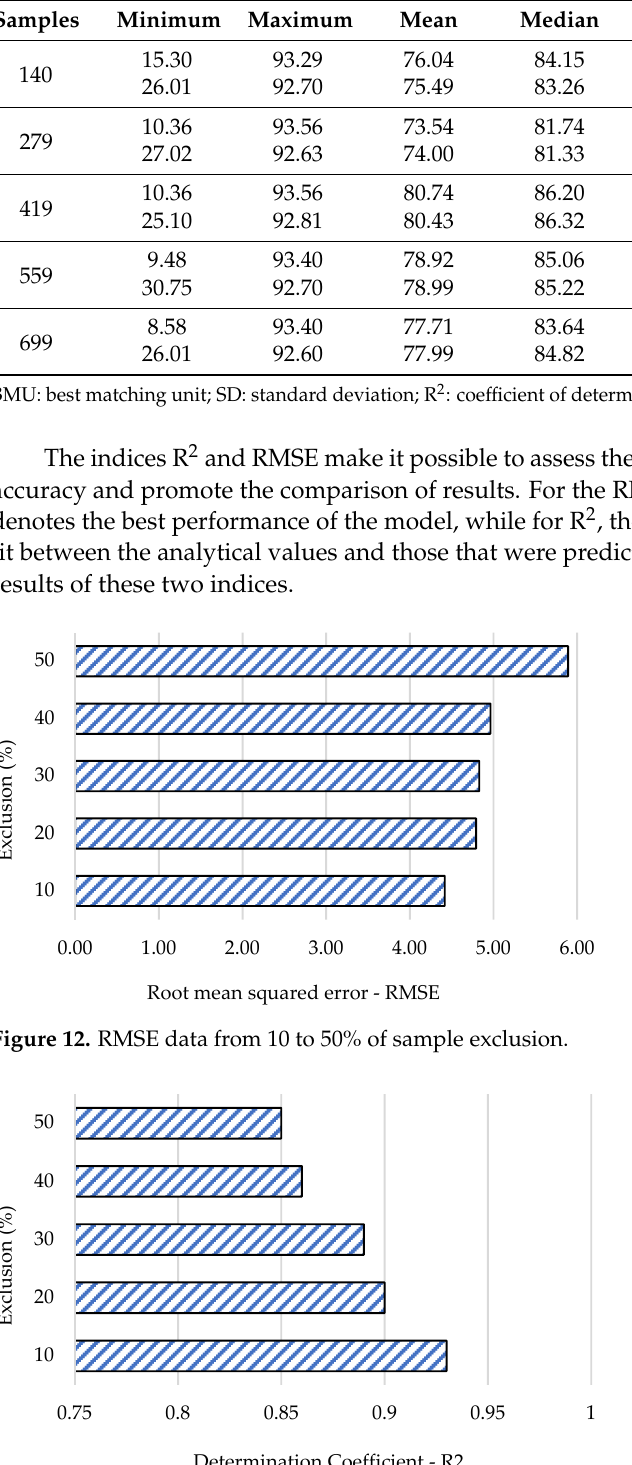
Table 5. Statistical analyses of the total recovery variable (from 10% to 50% of sample exclusion).